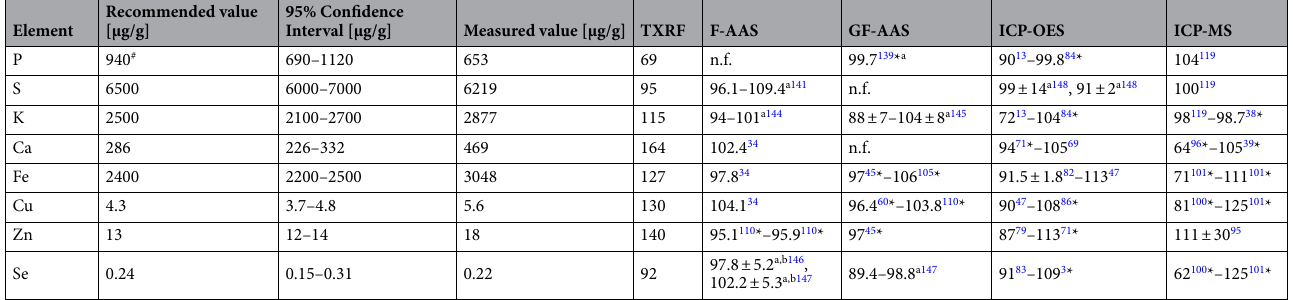
Table 7. Values of trueness [%] obtained using TXRF for the reference material IAEA-A-13 together with the lowest and highest values of the parameter met in examined literature. # Information value; *Calculated based on the literature data; a Value from the paper that does not concern the analysis biomedical samples; b Determined using HG-AAS; n.f. Value not found in discussed papers or not expressed in consistent unit.